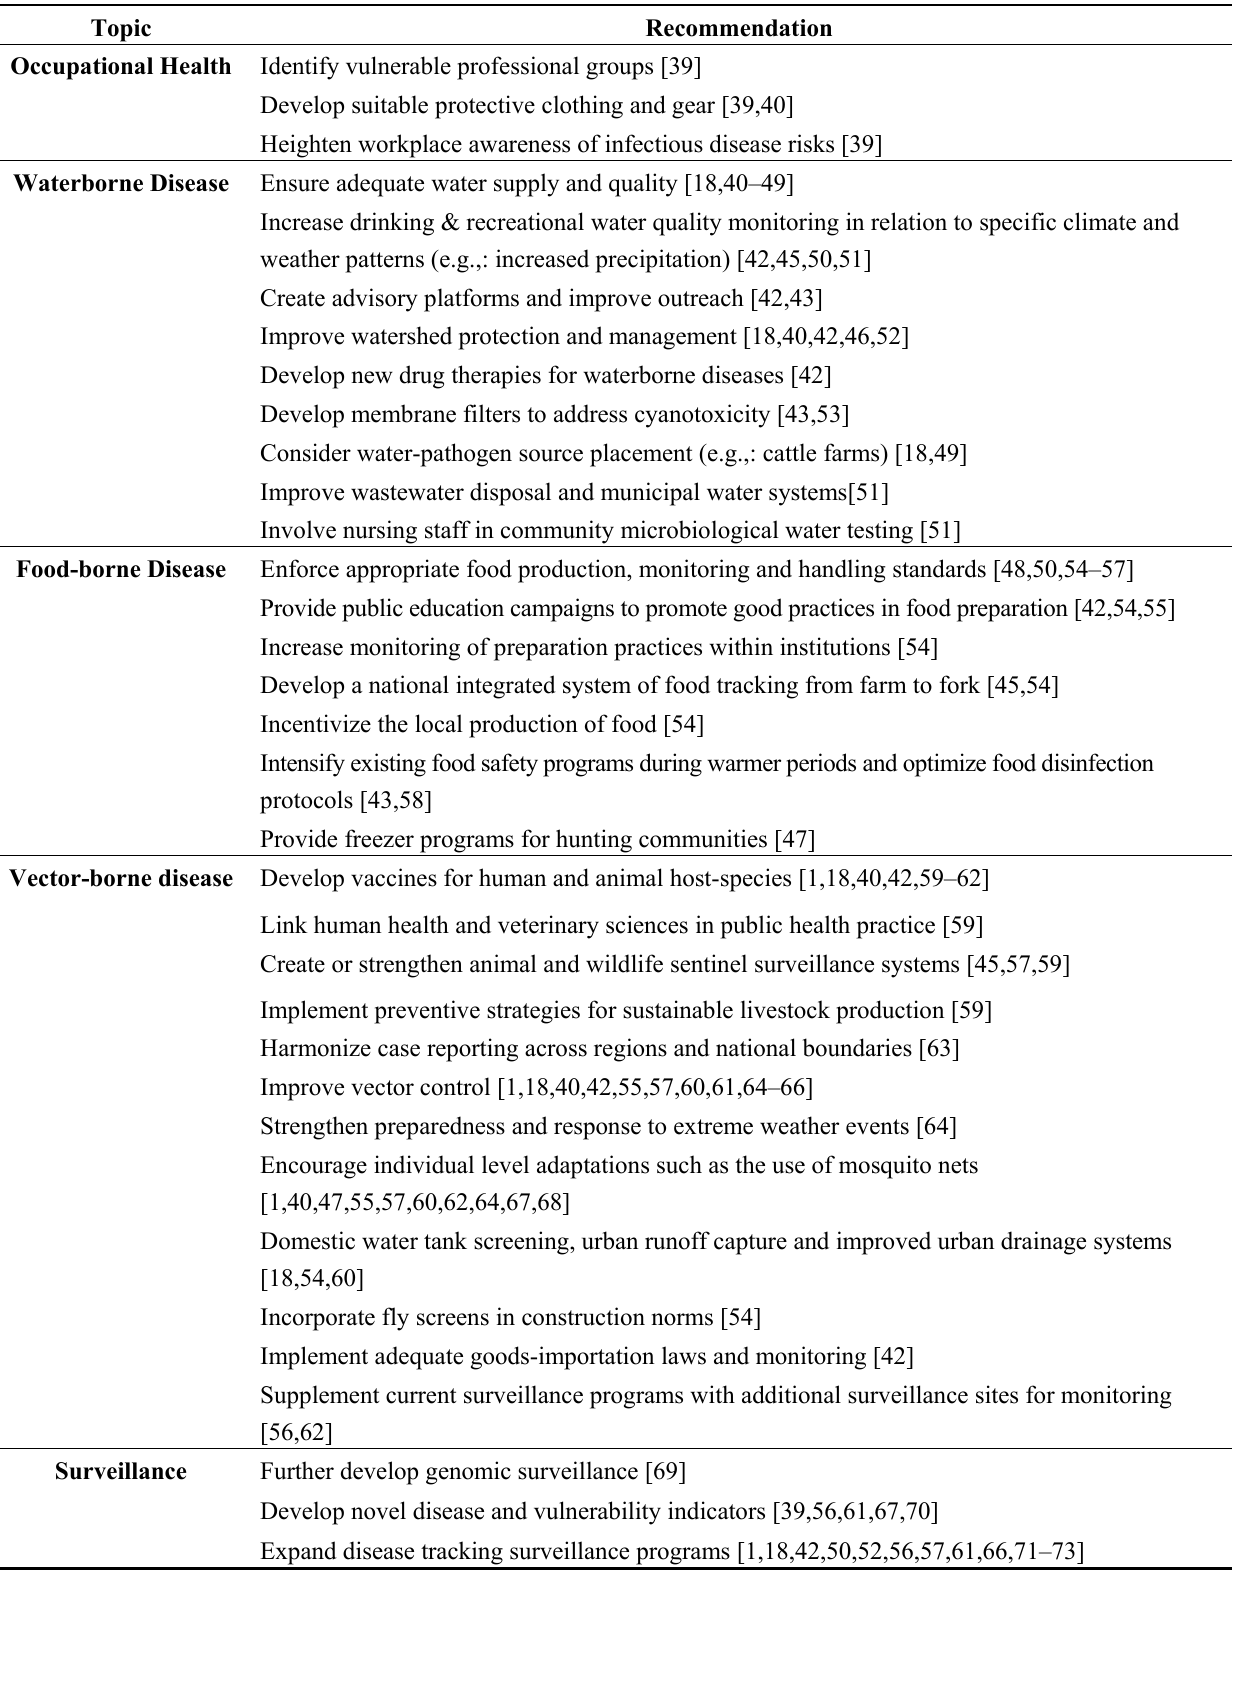
Table 3 . Recommended public health adaptation strategies in the peer-reviewed literature. Topic Recommendation Occupational